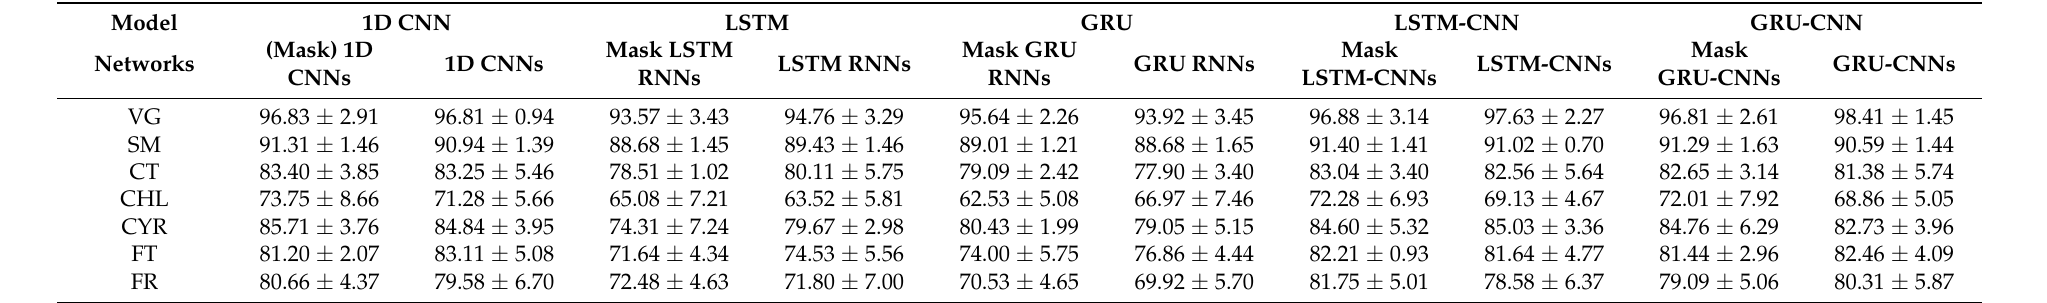
Table 4. Average F1 scores and standard deviations (over five different random splits) per crop type attained by the five deep learning models using unfilled Sentinel-2 time series data (the “Mask” networks) and filled Sentinel-2 time series data; the values in bold are the higher average F1s per crop type based on the same model. VG, vegetable greenhouse; SM,